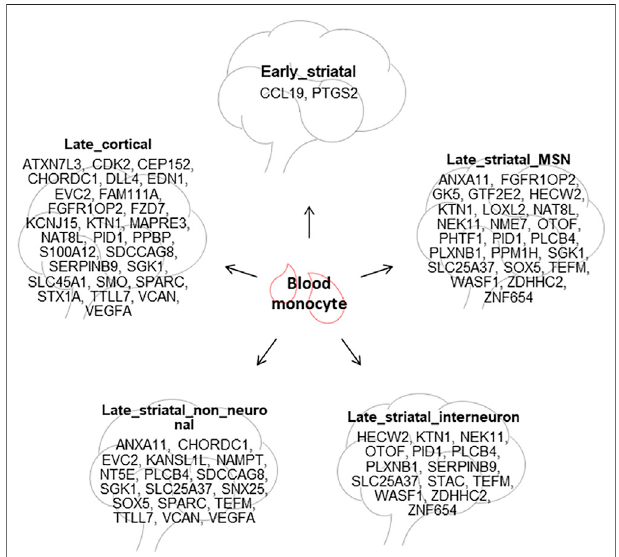
FIGURE 8 | Potential blood biomarkers for HD. The common DEGs